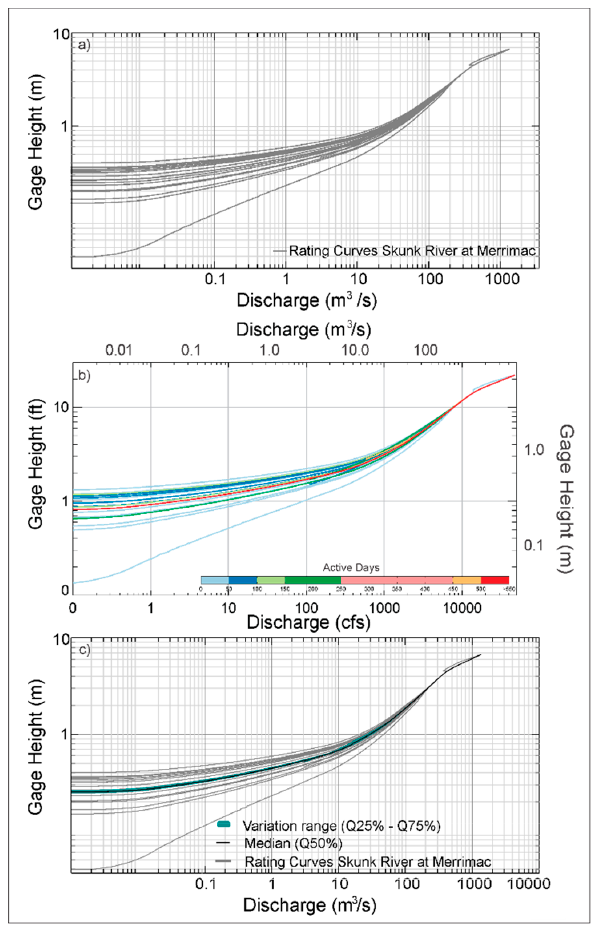
Figure 7. Rating curve changes over time in Skunk River at Merrimac. ( a ) adjusted rating curves; ( b ) duration of each rating curve (in days); ( c ) quantiles for each value of discharge. Hydrology 2020 , 7 , x FOR PEER REVIEW